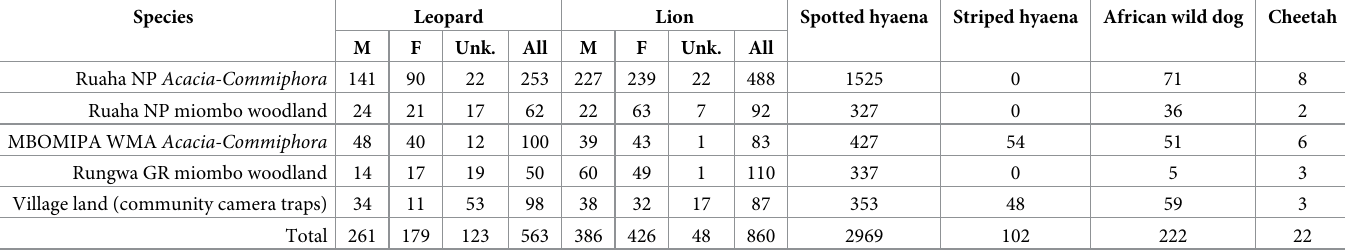
Table 1. Number of large carnivore capture events at each survey site. Species Leopard